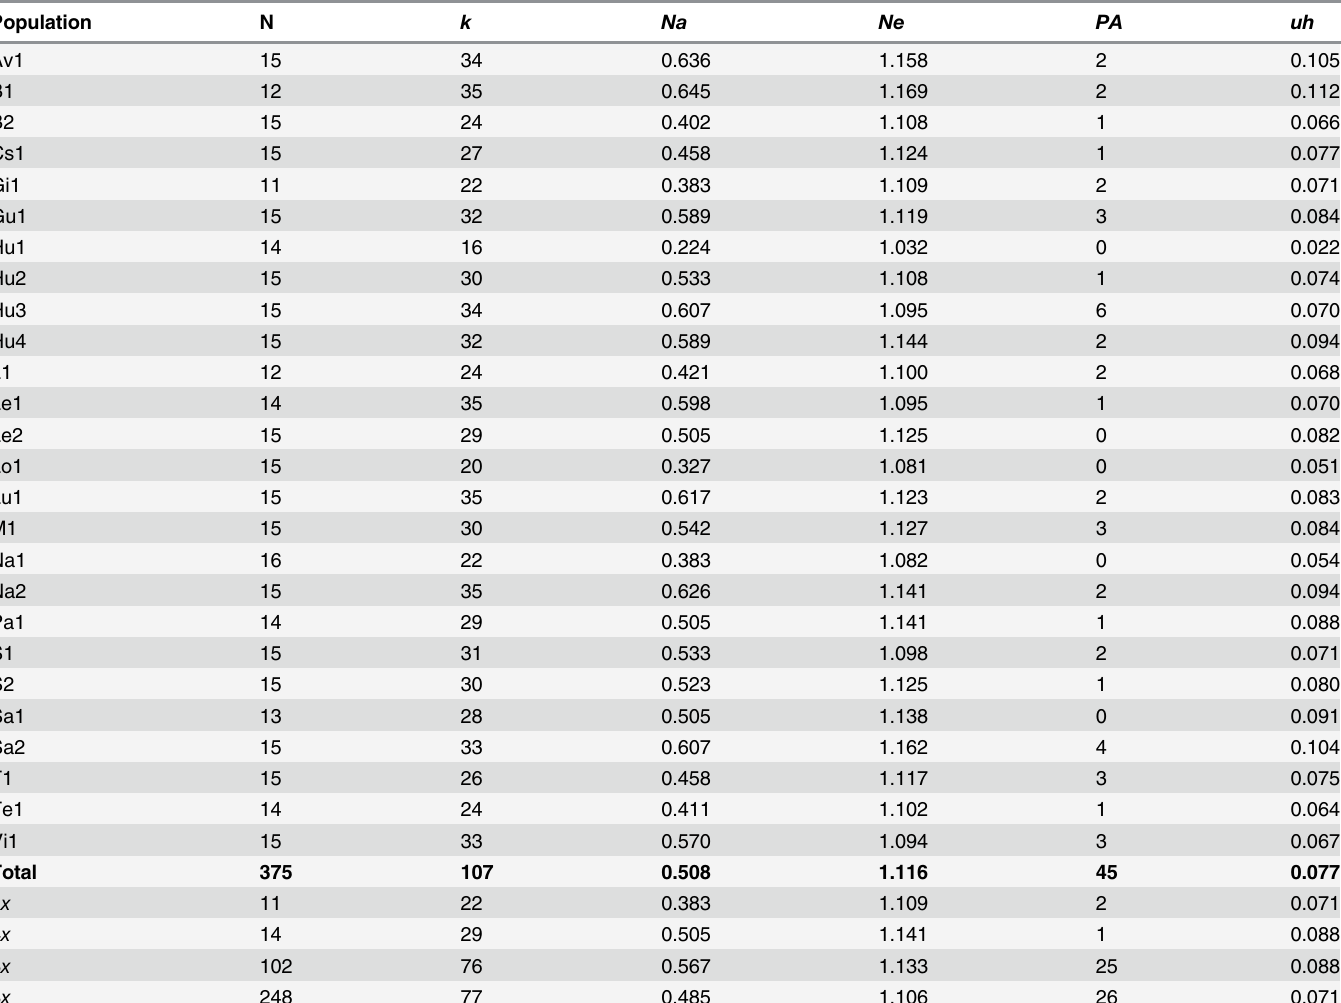
Table 2. Main parameters of genetic diversity for the 26 populations surveyed and the four ploidy levels of Spanish A . millefolium . N, number of indi- viduals; k , total number of alleles; Na , mean number of alleles; Ne , number of effective alleles; PA , number of private alleles; uh , unbiased diversity. For abbre- viations of populations, see Table